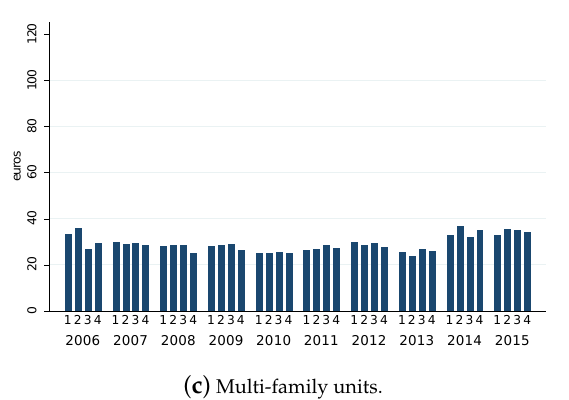
( c ) Multi-family units. Figure 3. Average water bill per quarter by family unit (in e /quarter/unit). 1, 2, 3 or 4 for January– March, April–June, July–September and October–December,